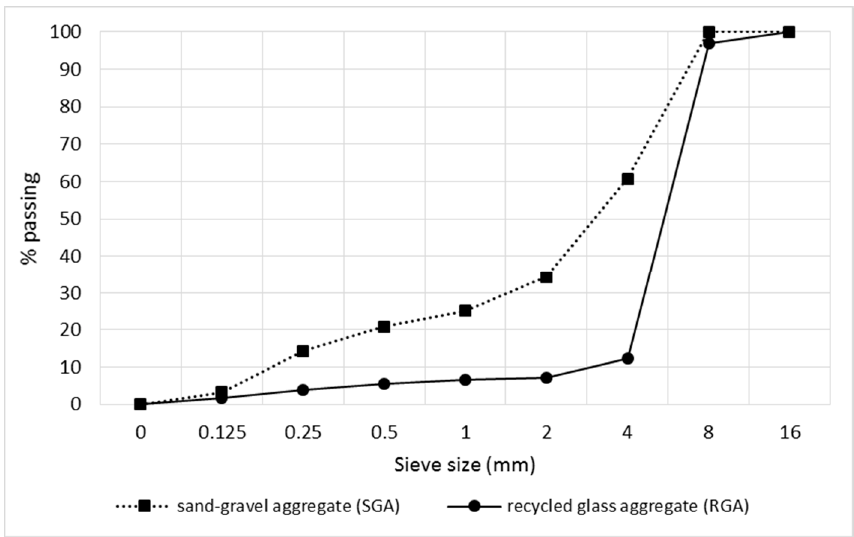
Figure 2. Particle size distribution curve for the recycled glass aggregate (RGA) and the traditional aggregate i.e., a sand-gravel mixture (SGA).